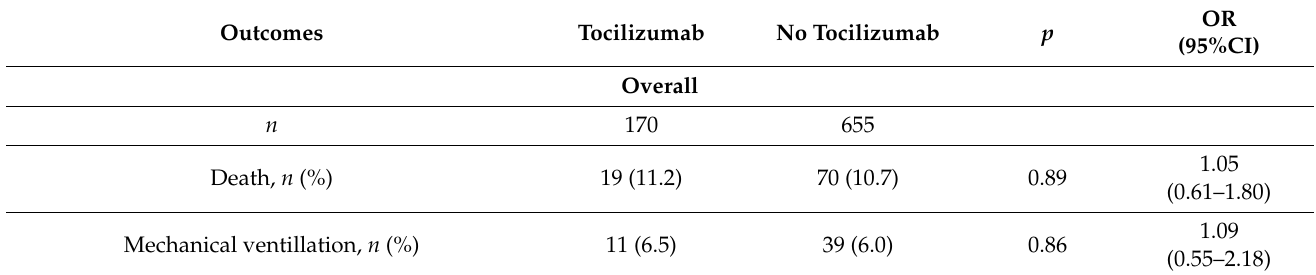
Table 2. Tocilizumab effect on rates of death, need for mechanical ventilation, and clinical improvement depending on possible outcomes